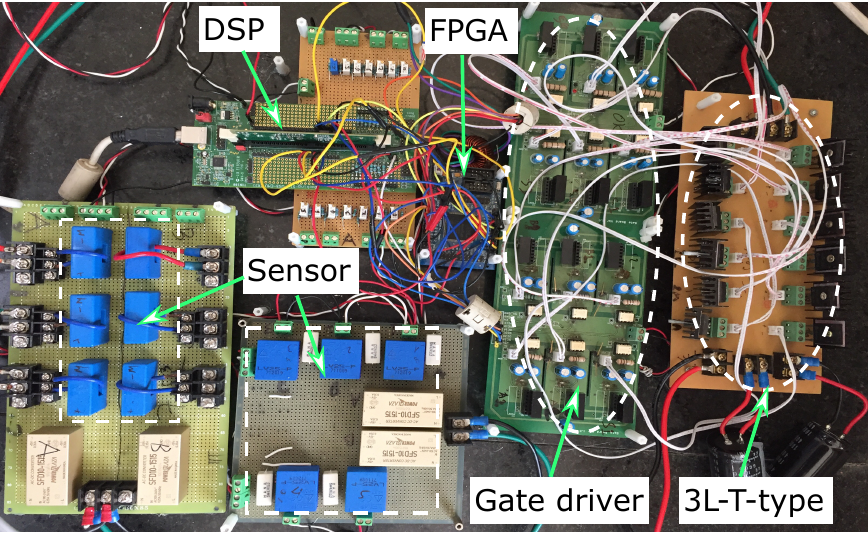
Figure 17. Experimental test bench in the laboratory.